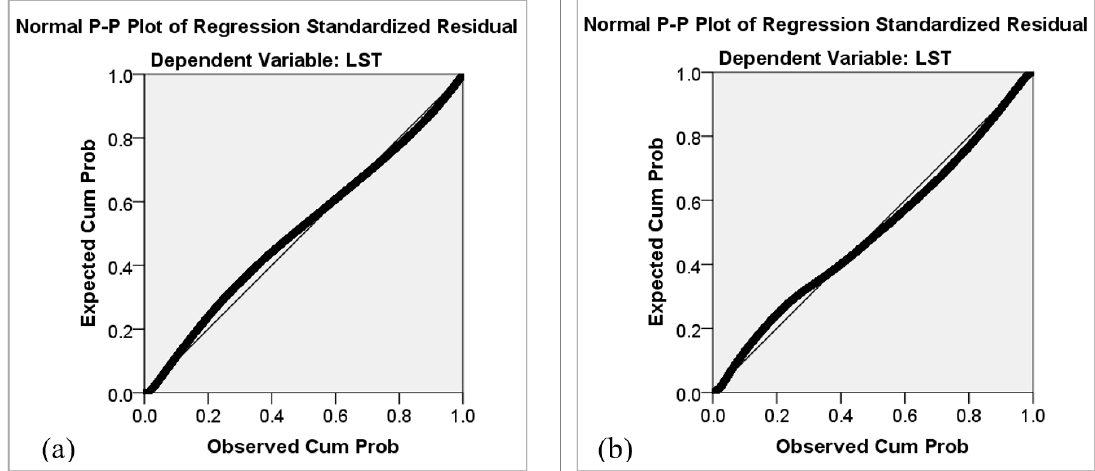
Figure 8. Expected cumulative probability vs. Observed cumulative probability plots (P-P plot) for Panaji ( a ) and Tumkur ( b ).